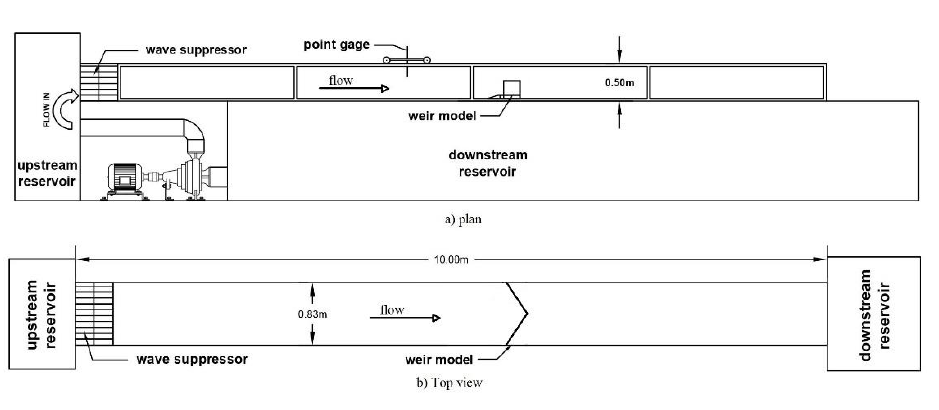
Figure 3. An overview of the laboratory flume used in this